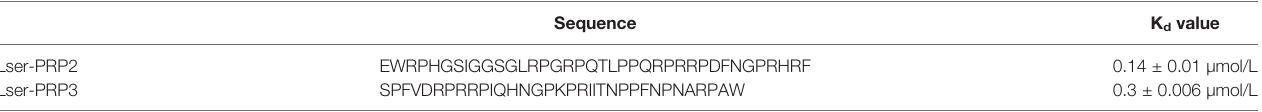
TABLE 2 | Sequences of Lucilia sericata proline rich peptides with N-terminal modi fi cation with 5(6)-carboxy fl uorescein and C-terminal amidation (NH 2 ). Sequence